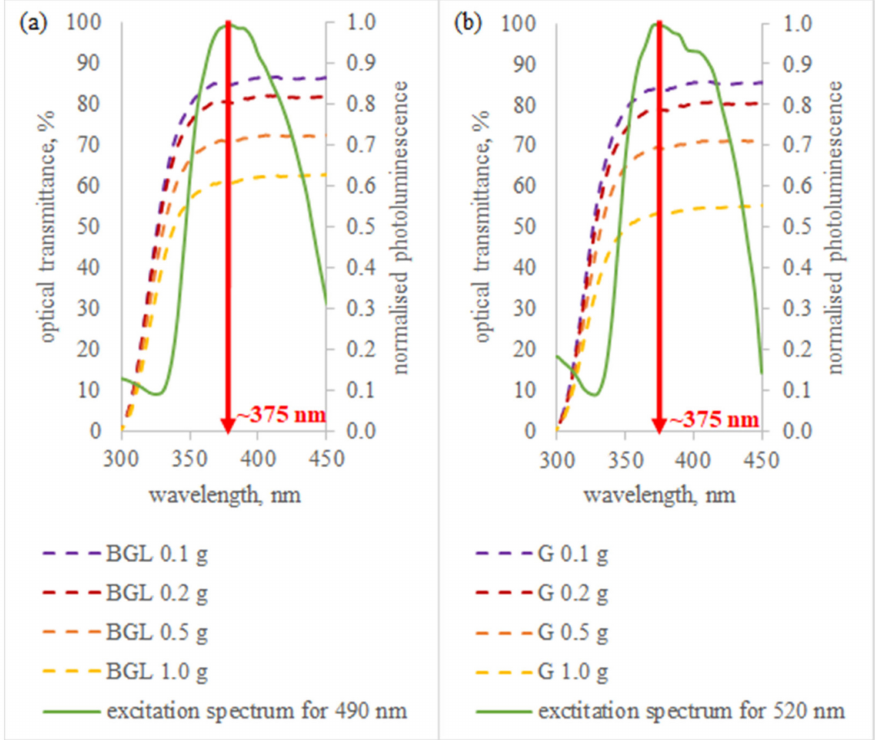
Figure 5. The optical transmittance characteristic of layers prepared with spray-coating method based on BGL ( a ) and G ( b ) pigments in isopropanol variant and the excitation spectrum of BGL ( a ) and G ( b